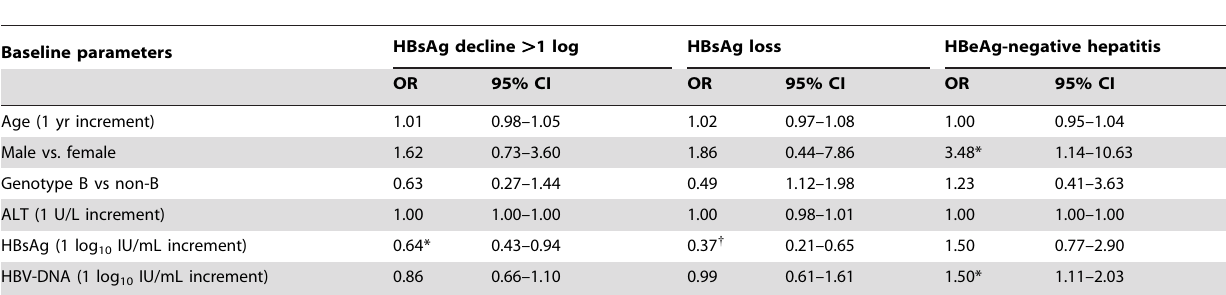
Table 4. Predictors for HBsAg decline . 1 log at end-of-follow-up, HBsAg loss and HBeAg-negative hepatitis by multivariate analysis.